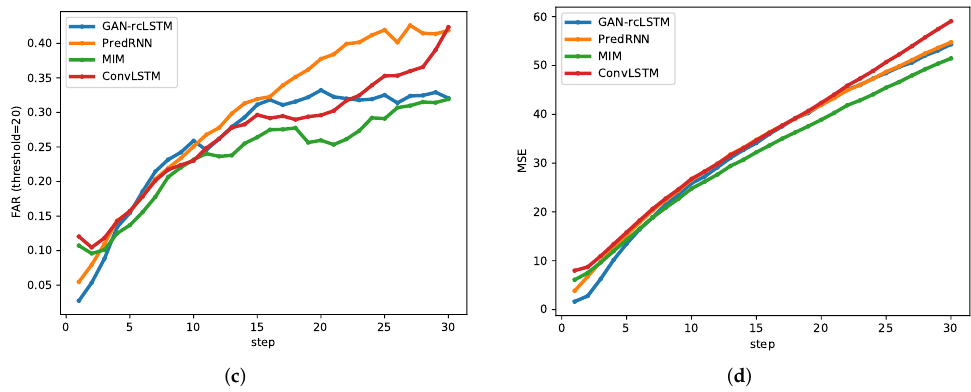
Figure 6. Comparison of predictions from different models for the next 30 frames, with a 6-min interval between each frame. ( a ) is the Critical success index (CSI), ( b ) is the probability of detection (POD), ( c ) is the false alarm rate (FAR), and ( d ) is the mean square error (MSE). High CSI and POD curves indicate more accurate hits, low MSE and FAR curves indicate lower errors and false positives.